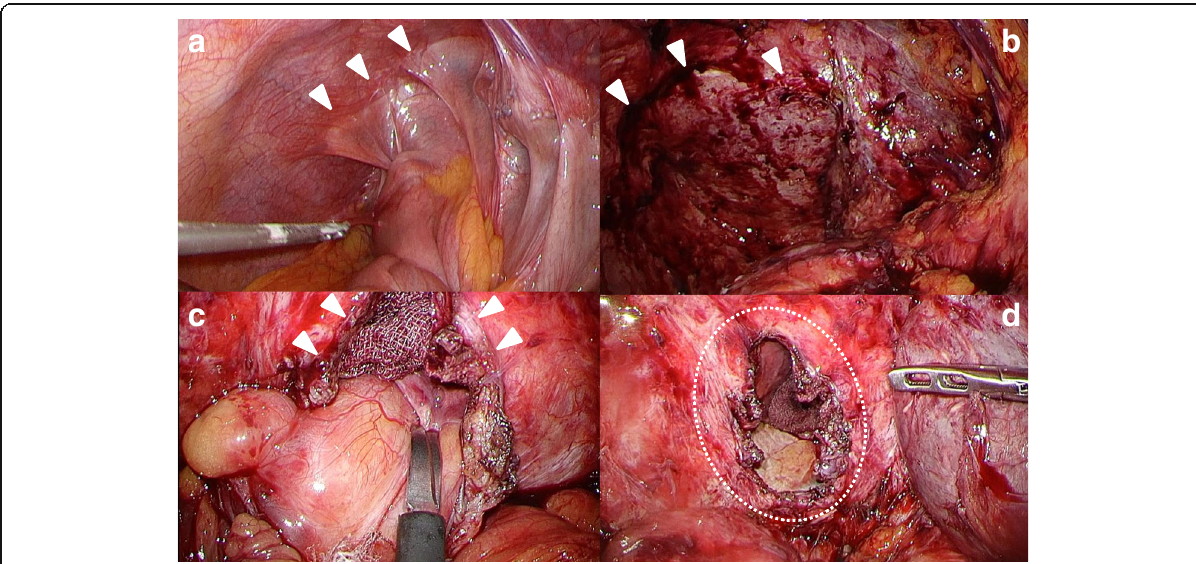
Fig. 2 Operative findings. a The transverse colon and small intestine anastomosis were found to be adherent to the right hemi diaphragm (arrow heads). b The images show the surface of the liver with adhesions (arrow heads). c The transverse colon was incarcerated in the diaphragmatic